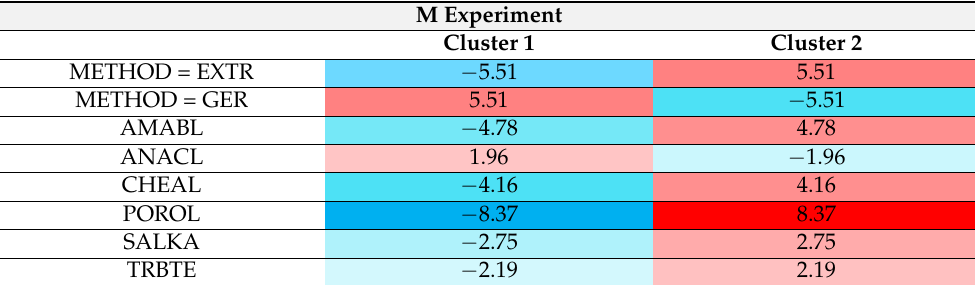
Table 2. Description of the relationship between the quantitative weight of data species and the categorical variable method in M experiment.